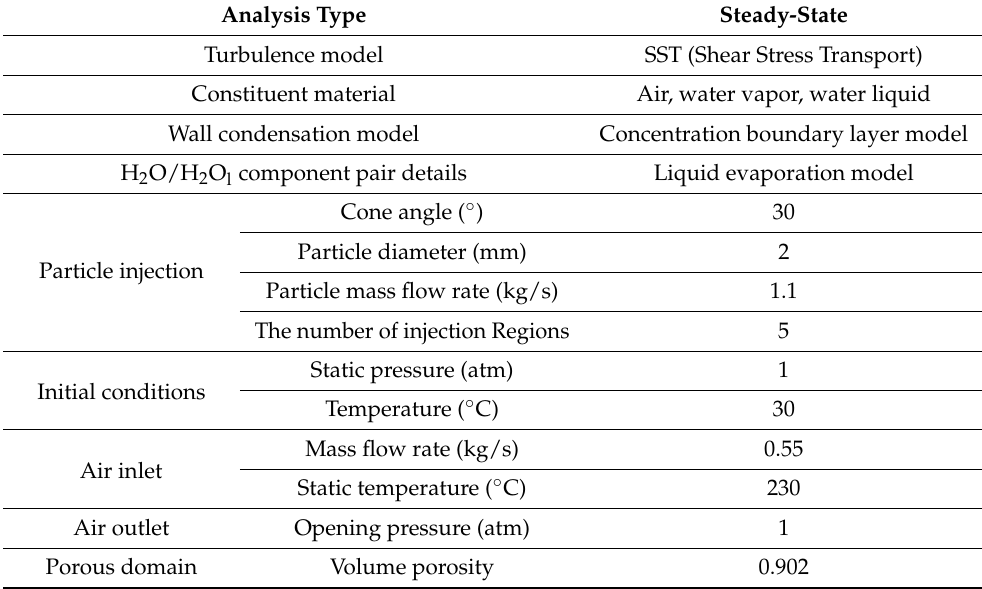
Table 3. Calculation conditions.